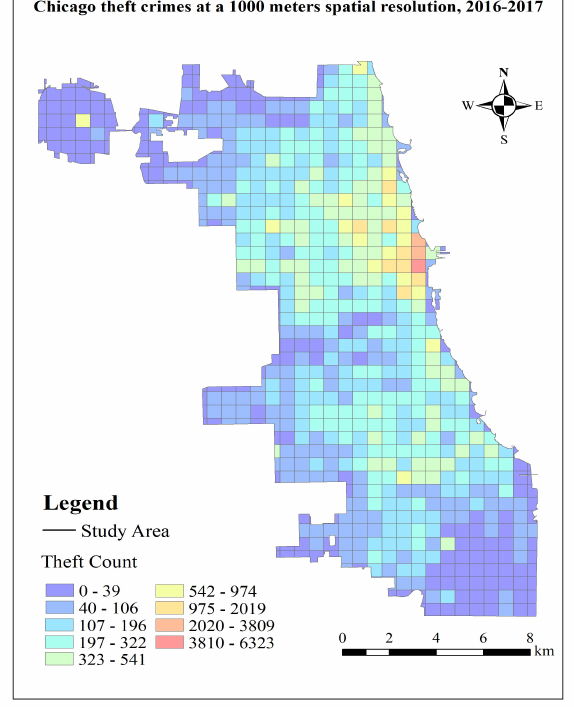
Figure 3. The study area and the distribution of theft crimes in 1000 meters.